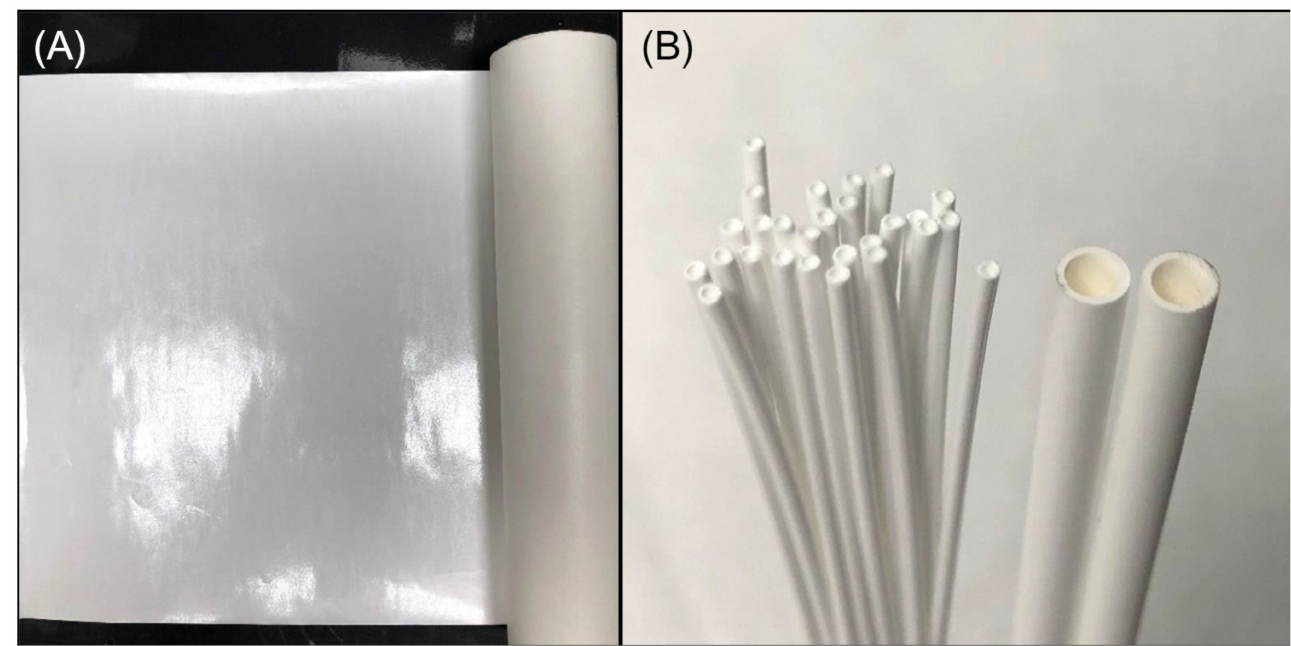
Figure 1. Photos of ( A ) FS and ( B ) hollow fiber (left)/tubular (right) membranes. Reprinted with permission from Ref. [20]. Copyright 2021,